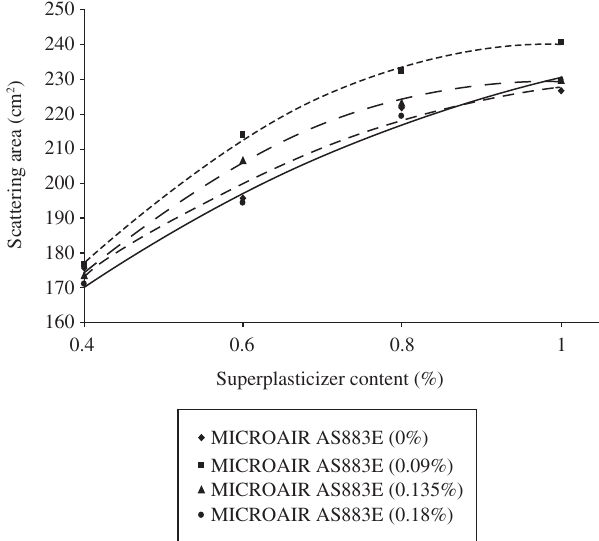
Figure 4. Scheme of the behavior of concrete with and without silica fume. a) Phenomenon of internal bleed around the aggregate with elongated form; and b) confined aggregate – doping process with silica fume. Source: Liborio 7